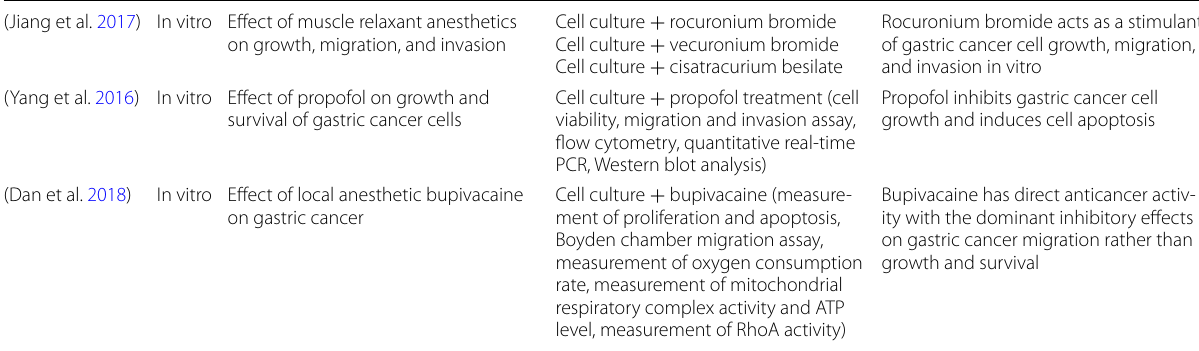
Table 3 Summary of studies on gastric cancer cells with anesthetic agents in in vitro conditions (Jiang et al. 2017) In vitro Effect of muscle relaxant anesthetics on growth, migration, and invasion (Yang et al. 2016) In vitro Effect of propofol on growth and survival of gastric cancer cells (Dan et al. 2018) In vitro Effect of local anesthetic bupivacaine on gastric cancer